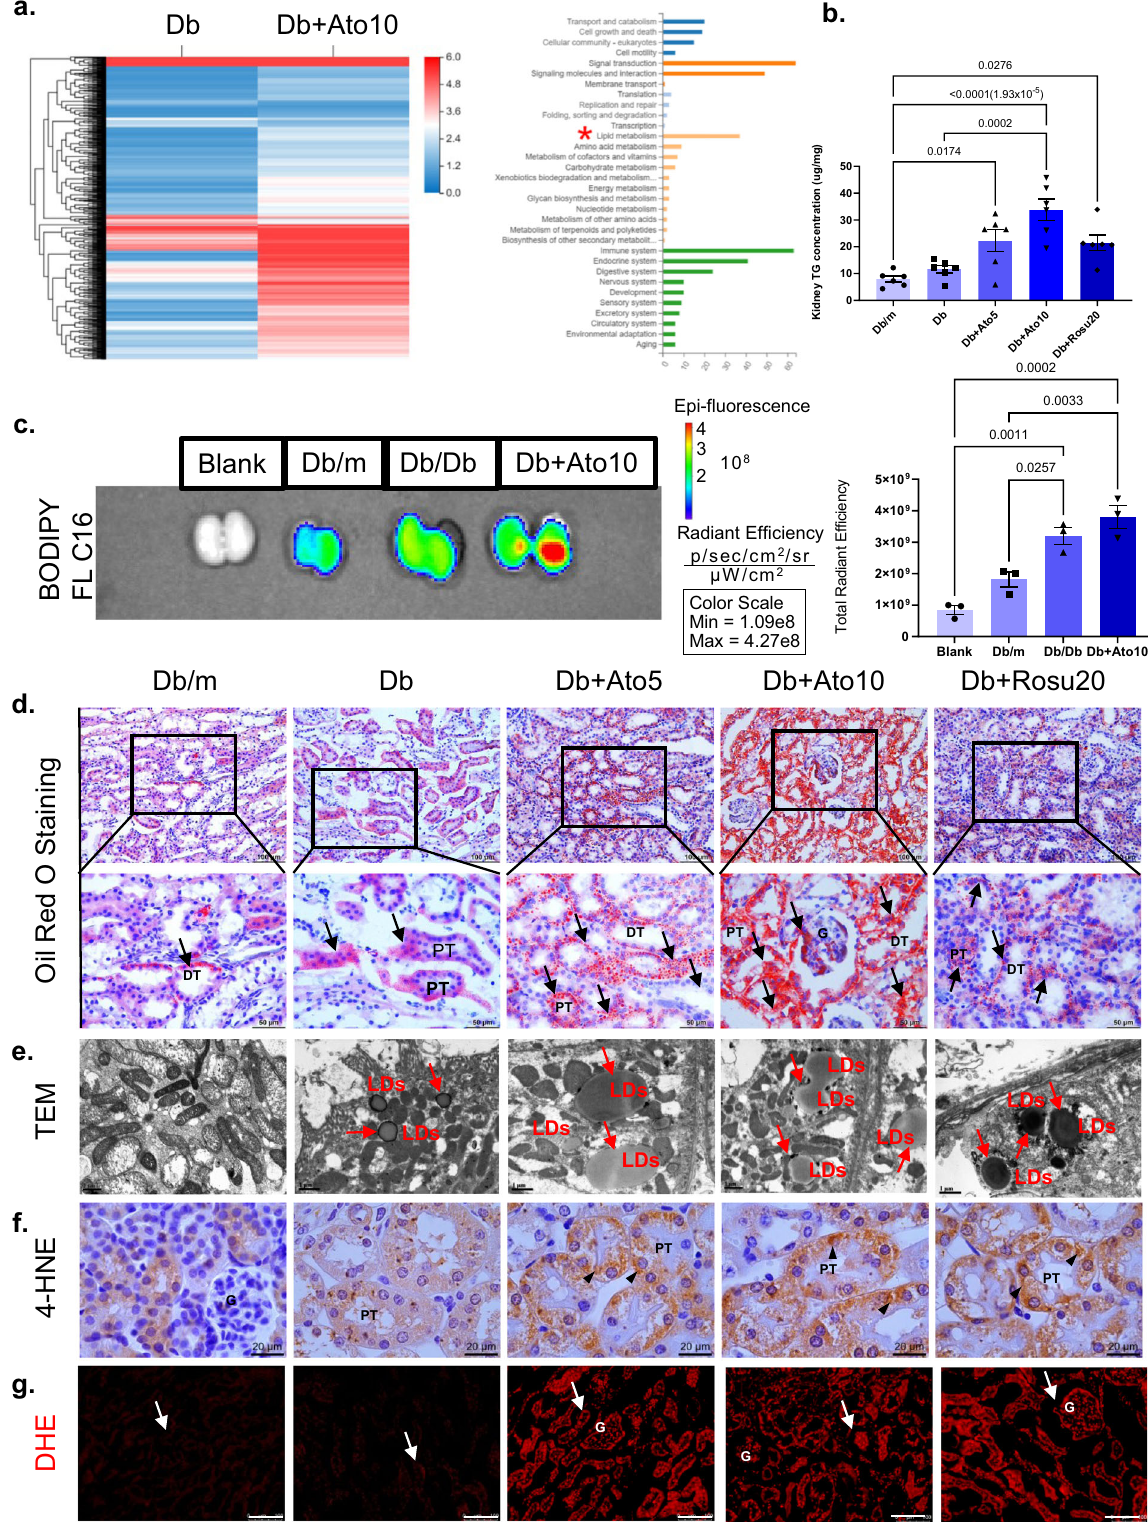
GFR measurement GFR was measured at 36 weeks of disease course. Db/db mice were injected retro-orbitally with FITC-sinistrin (7 mg 100 g − 1 body weight; MediBeacon, Germany). A miniaturized imager device (MediBeacon) was used to detect fl uorescence in the skin on the shaved back over 1 h. GFR was calculated on the basis of the kinetics